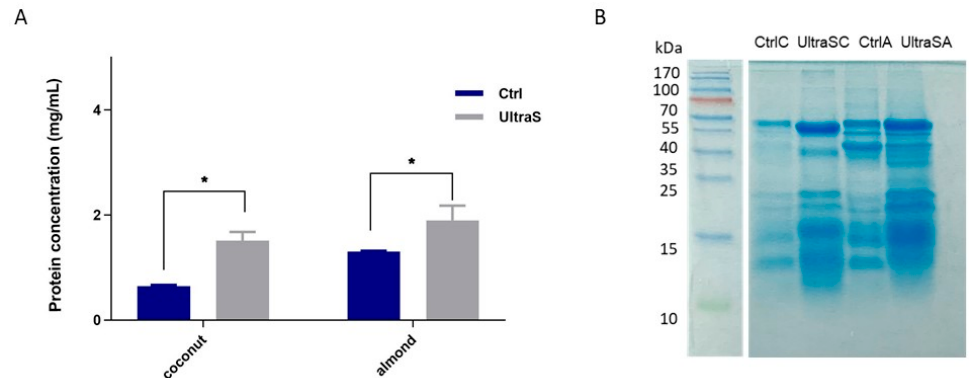
Figure 2. ( A ) Comparison of the “soluble protein” contents of coconut and almond samples: raw press cakes (Ctrl) and UAE treated freeze-dried liquid fractions (UltraS), * significantly different ( p < 0.05) versus the raw press cake. ( B ) Reduced SDS-PAGE protein profile of raw press cakes (CtrlC and CtrlA) and the treated liquid fractions (UltraSC, UltraSA); M, pre-stained molecular marker. Each sample (10 μ L) was added to 10 μ L of loading buffer, loading 20 μ L for each well.